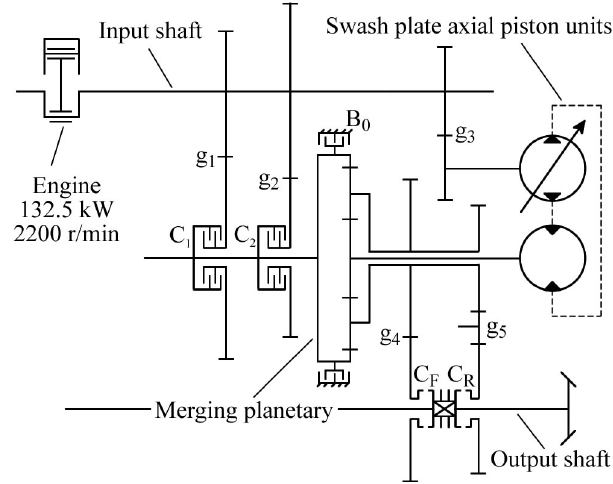
Figure 1. Principle of continuously variable cotton picker transmis- sion.